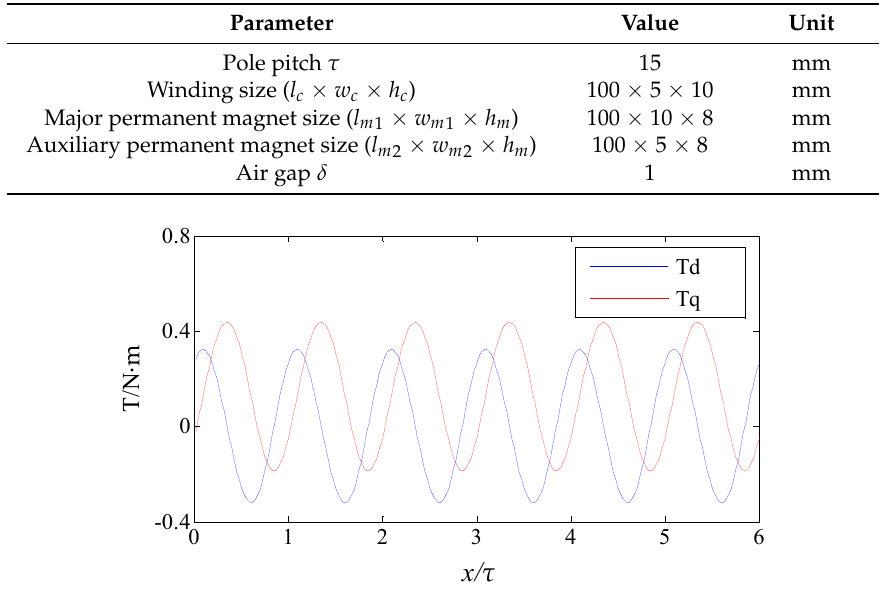
Figure 3. Additional torque caused by i d and i q .